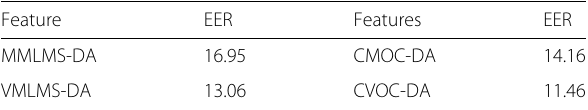
Table 5 Comparison with modified log magnitude spectrum on ASVspoof 2017 V2 evaluation set in terms of EER (%) Feature EER